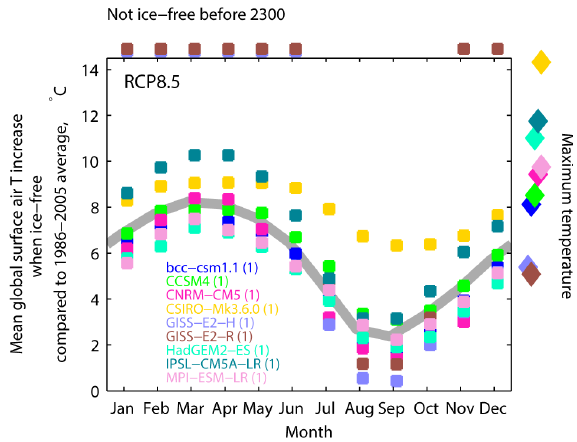
Figure 6. Global mean annual surface air temperature increase com- pared to 1986–2005 average, at which the Arctic Ocean becomes sea ice-free for RCP8.5. The multi-model mean is shown by the thick gray line. Months for which sea ice does not disappear are given as symbols above the graph. The maximum global surface temperature increase for each simulation is shown to the right of each